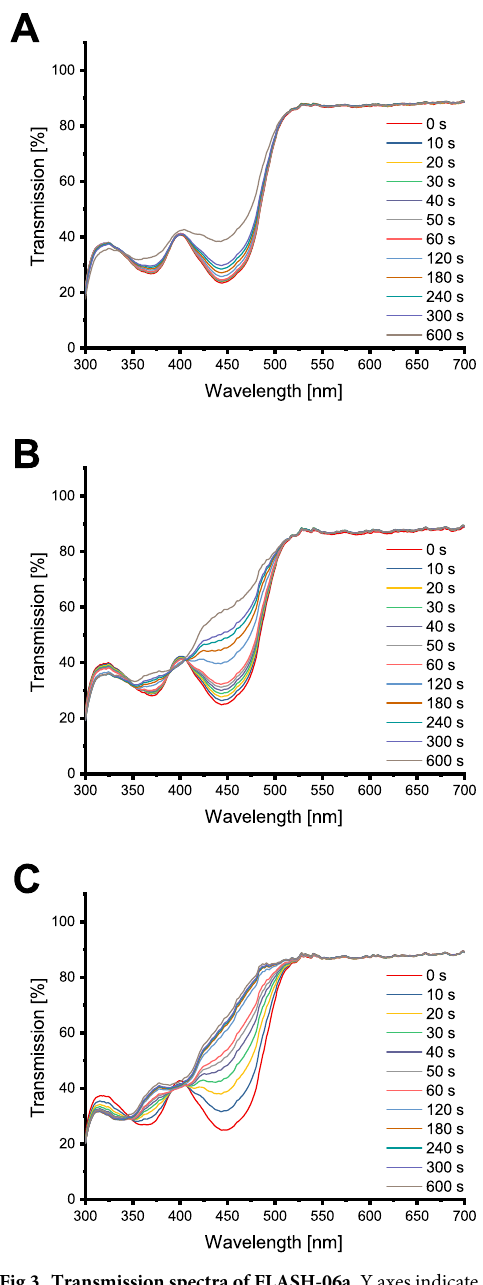
Fig 3. Transmission spectra of FLASH-06a. Y axes indicate the transmission in per cent, x axes the wavelength in nm. Various colors of the spectra indicate different irradiation times. (A) shows the results for H 2 O, (B) for 75 mmol l -1 sodium phosphate and (C) for 75 mmol l -1 sodium carbonate. isosbestic points at 348 (CV = 1.24%), 389 (CV = 0.68%) and 405 nm (CV = 0.83%) (Fig 3B). Interestingly, the isosbestic points for carbonate were about the same wavelength as for phos- phate with 346 nm (CV = 1.17%), 393 nm (CV = 1.75%) and 402 nm (CV = 1.95%) (Fig 3C). However, chemical reaction was more pronounced with less light exposure for carbonate. The transmission data are shown in the S2 Dataset.